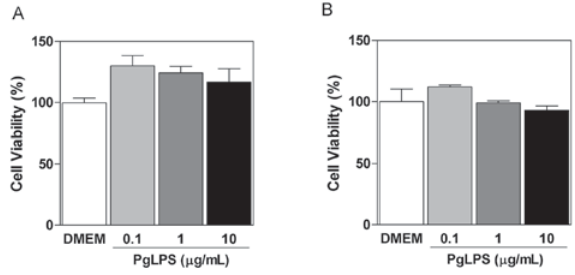
Figure 2- (cid:2) (cid:3)(cid:9)(cid:16)(cid:16)(cid:2) "(cid:10)(cid:5)(cid:20)(cid:10)(cid:16)(cid:10)(cid:8)(cid:22)(cid:2) (cid:12)(cid:14)(cid:2) (cid:15)(cid:9)(cid:13)(cid:8)(cid:5)(cid:16)(cid:2) (cid:17)(cid:18)(cid:16)(cid:17)(cid:2) (cid:19)(cid:20)(cid:6)(cid:12)(cid:20)(cid:16)(cid:5)(cid:21)(cid:8)(cid:21)(cid:2) challenged with P. gingivalis LPS. Cultured dental pulp